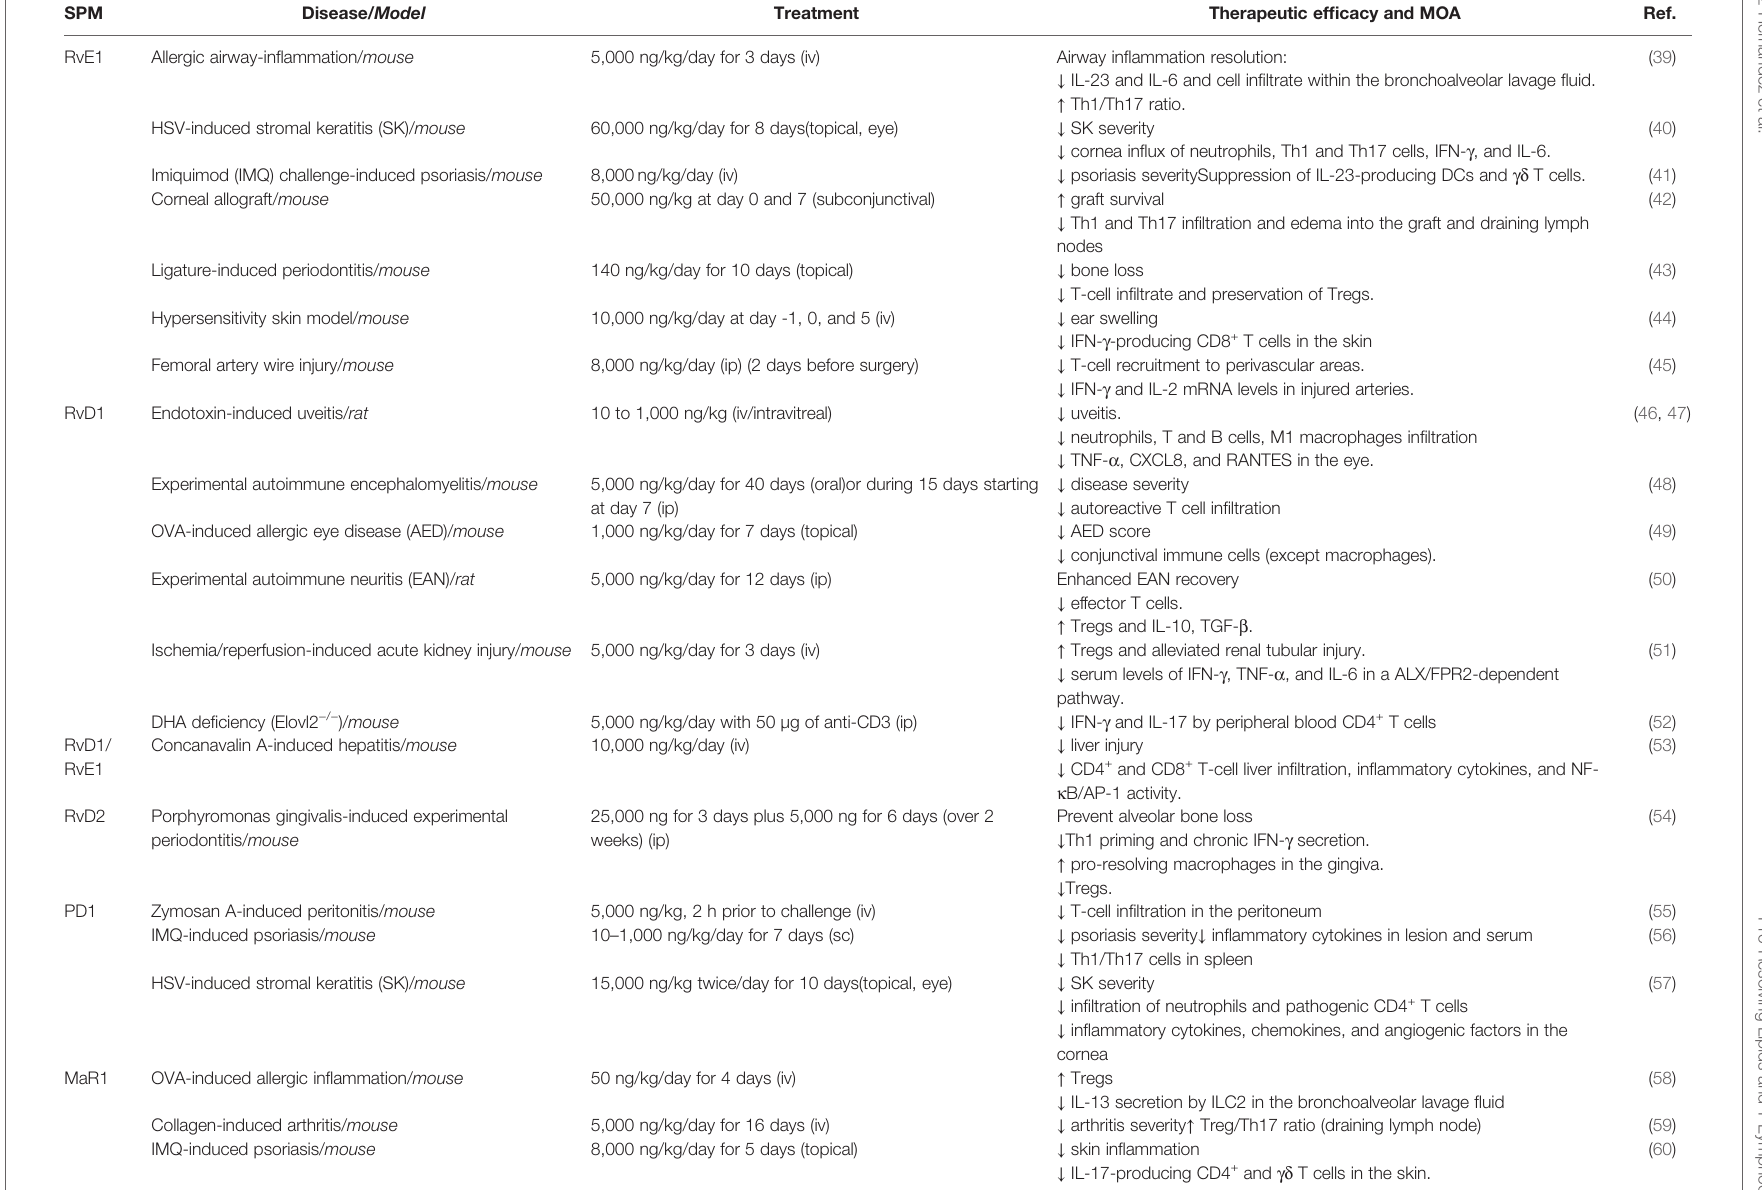
TABLE 1 | In vivo treatment with SPMs and impact on T-cell subsets and